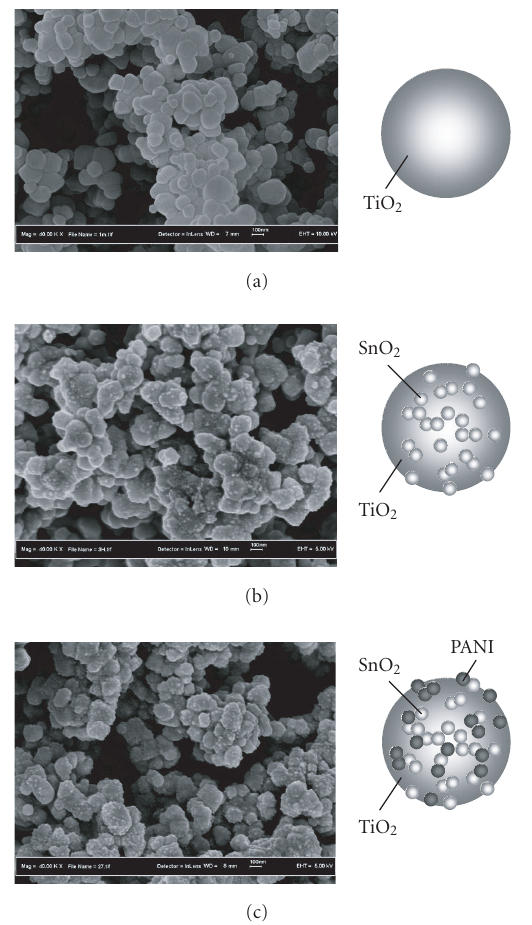
Figure 5: SEM photographs of (a) TiO 2 , (b) SnO 2 − TiO 2 , and (c) PANI-SnO 2 − TiO 2 .